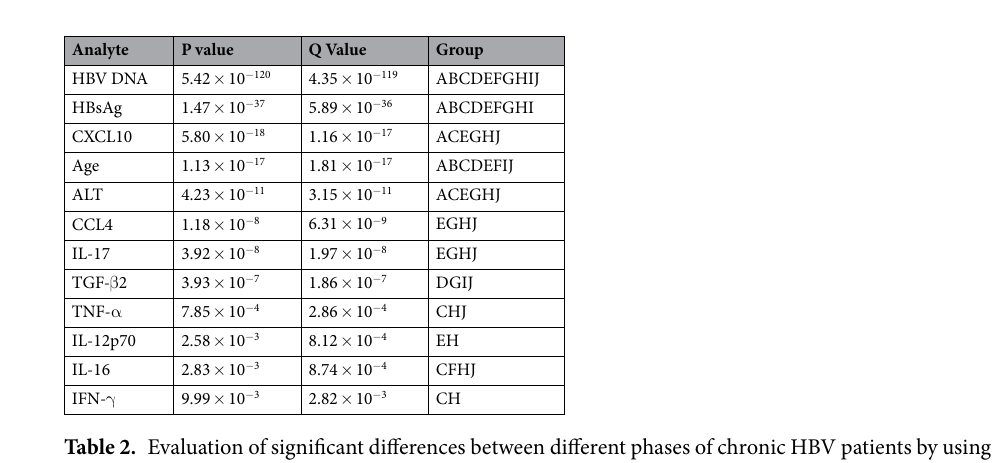
are visualized in Fig. S3. Of note, CXCL10 values were high in patients with acute hepatitis B and low in healthy controls and NA treated patients with HBV suppression. Cytokines in patients with HBeAg seroconversion. For 10 HBeAg positive patients with no history of (Table S3). The mean range between both time points was 4 years and 8 months (range 12 months–84 months). Comparing only those HBeAg seroconverters, who were considered as part of the EPI population before sero- conversion with the other EPI patients with unknown outcome, higher IL-12 levels ( − 0.13 ± 0.54 log 10 pg/mL vs. − 0.86 ± 1.05 log = 0.029) were documented (Fig. S4A). In addition, the seroconverters were younger 10 pg/mL; p than the rest of the EPI patients (6 ± 4 years vs. 20 ± 10 years; p = 0.008). After HBeAg seroconversion the values for TNF- α and ALT were lower than before in those patients ( − 0.31 ± 0.27 log 10 pg/mL vs. 0.34 ± 0.38 log 10 pg/ mL; p = 0.005 and 0.62 ± 0.13 ULN vs. 0.98 ± 0.19 ULN; p = 0.044). Analyzes of HBeAg seroconverters formerly grouped to EPH phase showed no difference in cytokine values, HBsAg titers or levels of transaminases compared to patients in the EPH phase with no documented HBeAg sero- conversion. When comparing HBeAg seroconverters classified as EPH patients before and after seroconversion, only IL-17 levels (0.47 ± 0.19 log 10 pg/mL vs. − 0.28 ± 0.40 log 10 pg/mL; p = 0.032), showed significant differences. Effect of IL-12 on T cell responses. To confirm the previously published data that IL-12 has an impact of HBV-specific T cell responses 16 , we have investigated the in-vitro effect of IL-12 on HBV core peptide stimulated PBMCs isolated from two young HBeAg positive patients with high HBsAg levels. After 10 days in-vitro HBV core peptide stimulation, CD4 + , as well as CD8 + T cells, showed higher IFN- γ /TNF production assessed by an intracellular cytokine assay after IL-12 plus HBV core peptide re-stimulation compared with peptide stimulation only (Fig. S4B).